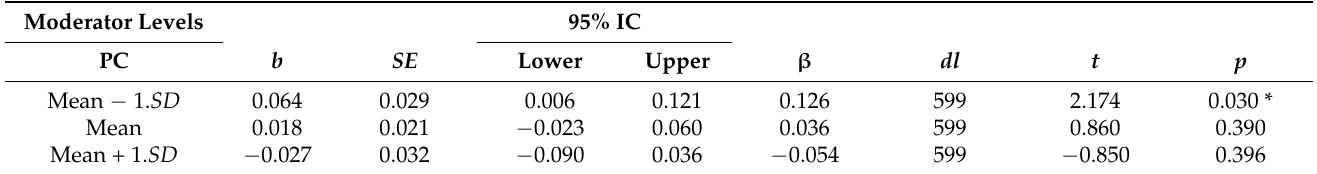
Table 4. Simple effects of GS attendance on prosocial behaviors at high, middle, and low perceived crowdedness of the